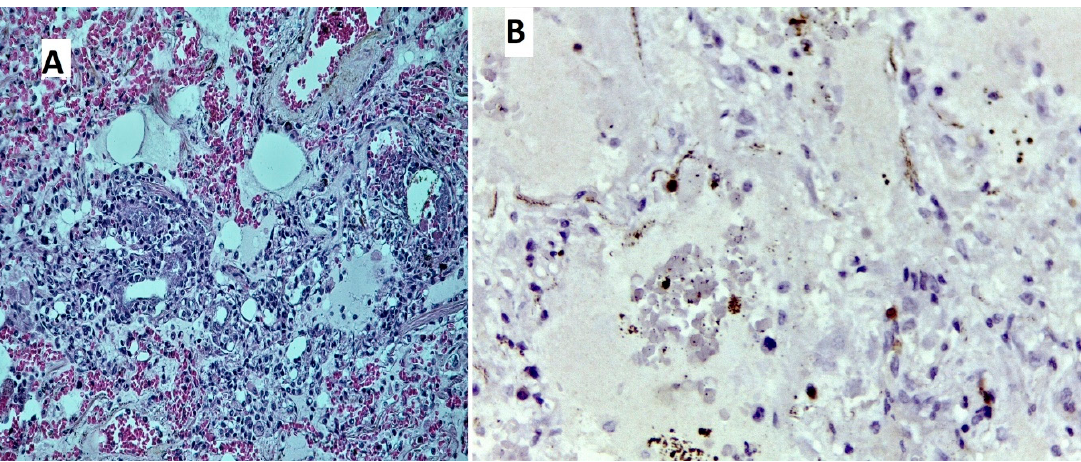
Figure 3. Tissue sample from left lung parenchyma, from the perihilar region, fixed in a 10% formaldehyde solution with a neutral Ph for a minimum of 72 h. ( A ) Diagnosis: hematoxylin–eosin (HE)-staining (200×-magnification). Small vessels with early organizing thrombus with red blood cells and surrounding fibrin accumulations (fibrino-hematic), leukostasis, and congestion. Alveolar walls are thickened due to acute distention of capillaries and interstitial oedema. Alveolar lumen is filled with pale-eosinophilic, finely granular content (transudate)— alveolar oedema— and neutrophilic and macrophagic elements. ( B ) Immunohistochemistry (400×-magnification), CD45RO positive, mostly in the